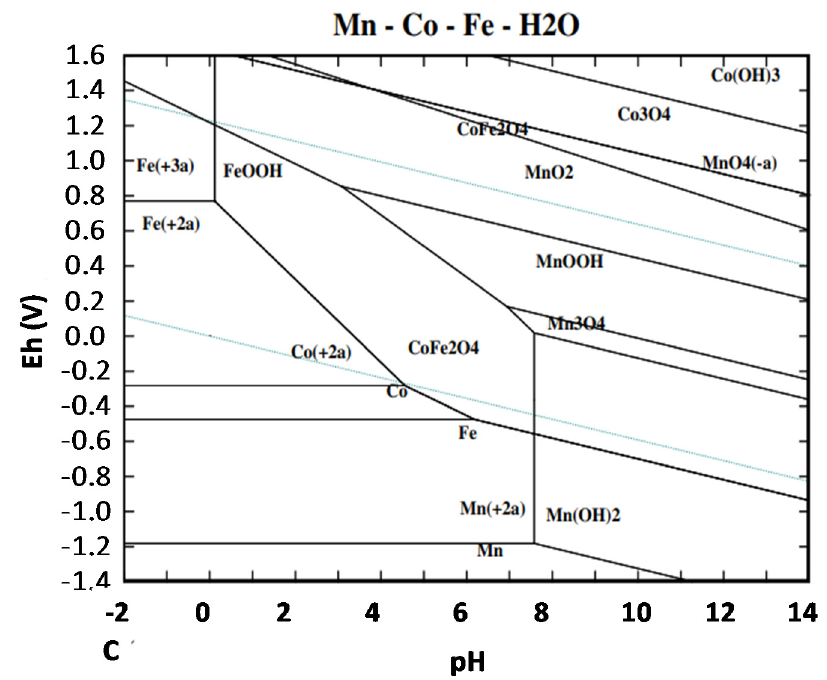
Figure 6. Potential pH diagram for the Mn-Co-Fe-H 2 O system at 25 °C and unit activity (based on HSC 6.1; dashed lines represent O 2 / H 2 O and H 2 O / H 2 couples). (Adapted from Senanayake [90].)